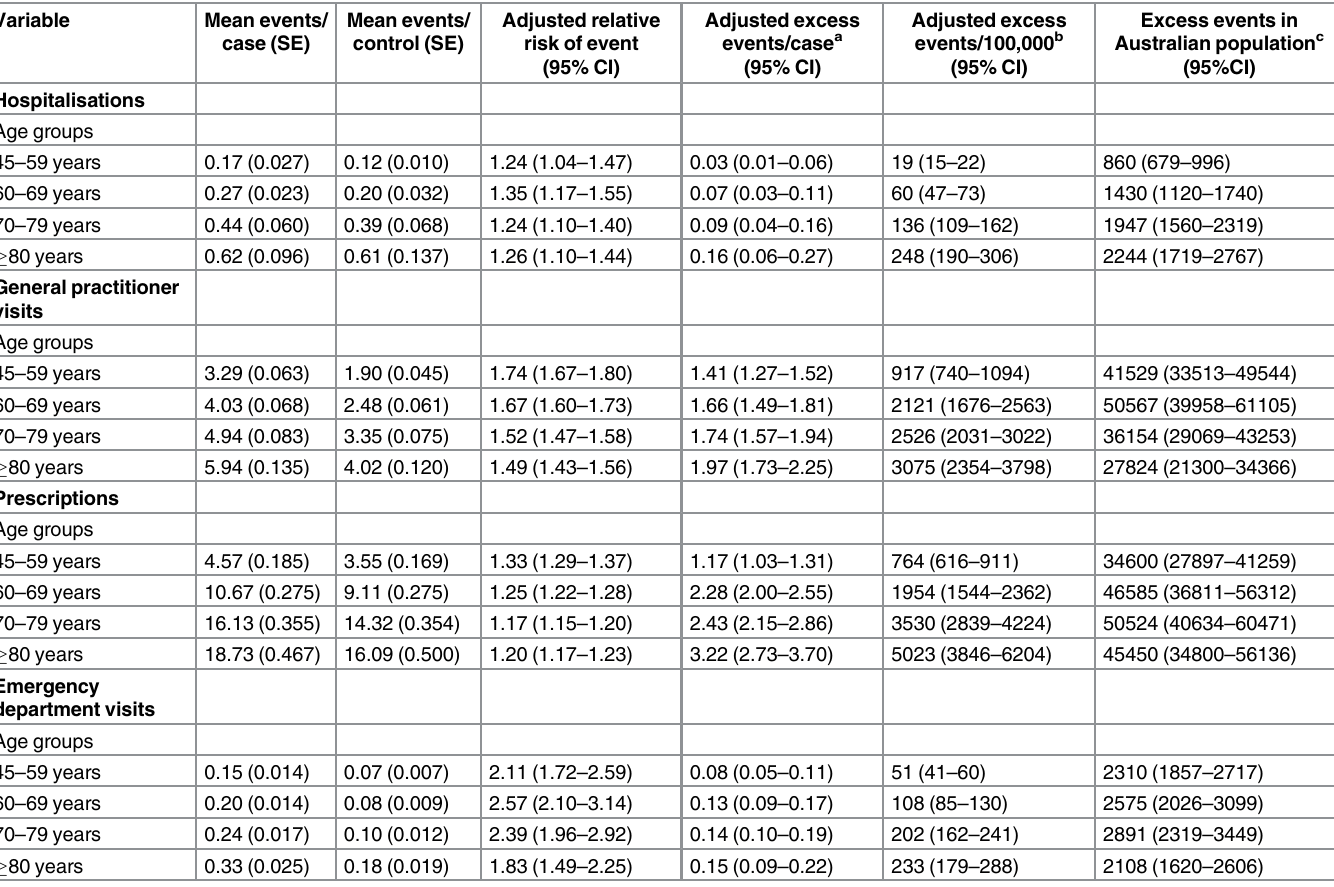
Table 2. Estimated excess healthcare usage (excess hospitalisations, general practitioner visits, prescriptions, and emergency department visits) due to herpes zoster in period 21 days prior and until 90 days after